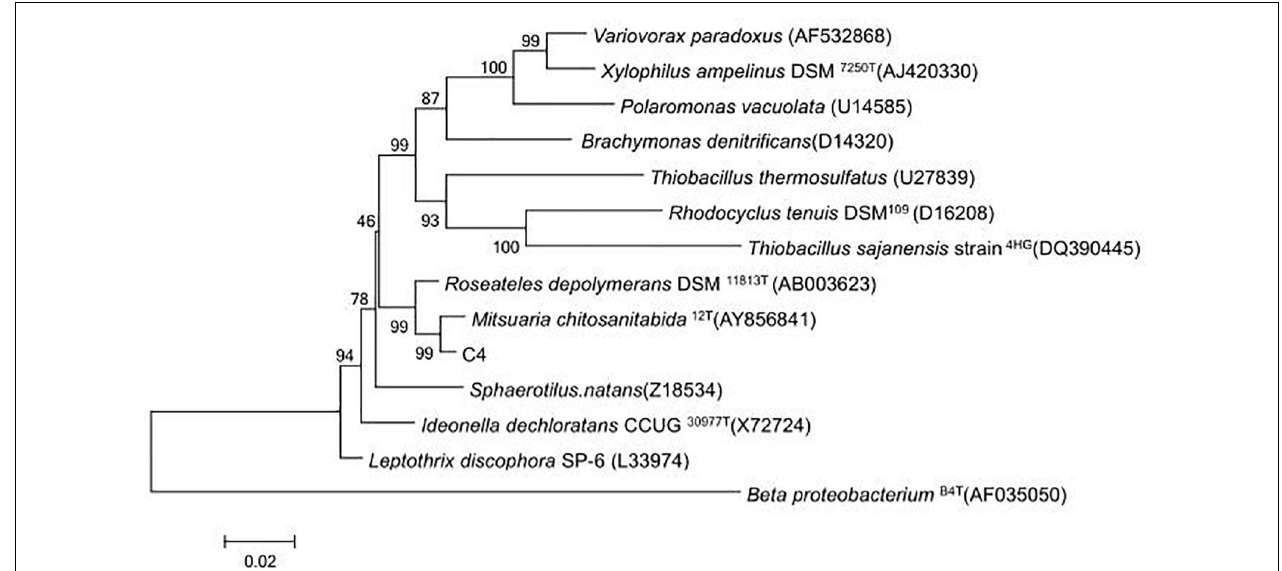
FIGURE 1 | Evolutionary tree based on 16S rDNA from strain C4 and other closely related species.